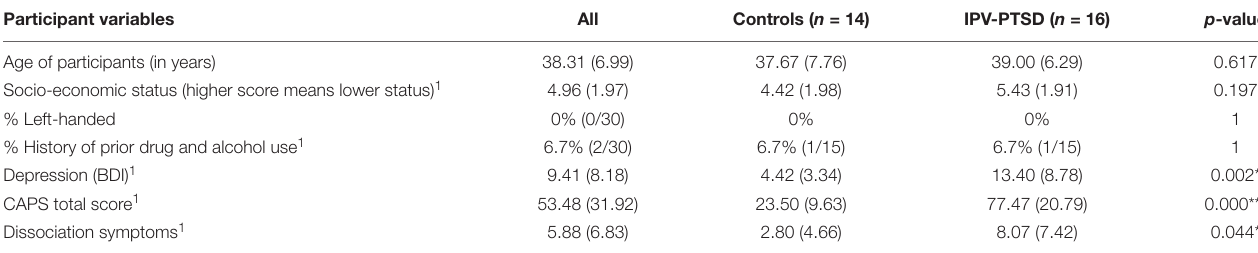
TABLE 1 | Demographic and clinical characteristics of IPV-PTSD and non-PTSD participants. Participant